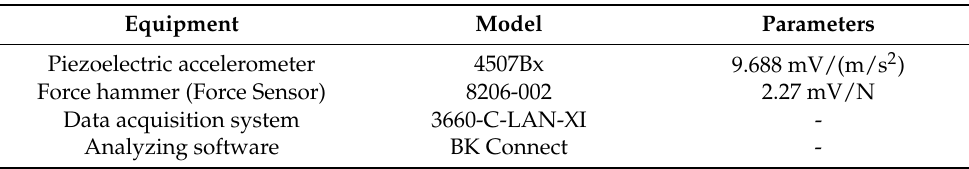
Table 3. Model and Parameters of Experiment Equipment.